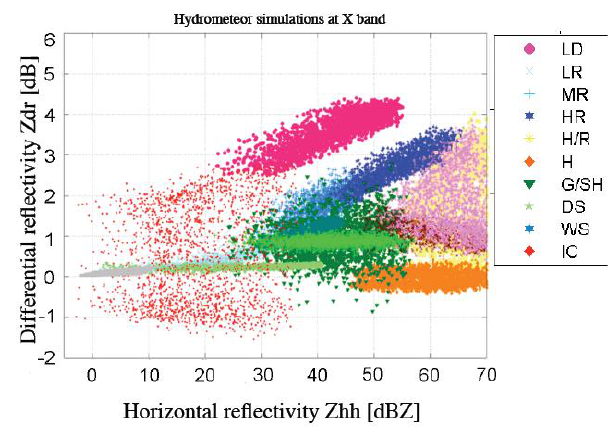
Figure 6. Scatterplot between Z hh and Z dr derived from numerical simulations at X band. The scatterplot is segmented as a function of hydrometeor classes that are colour-coded.